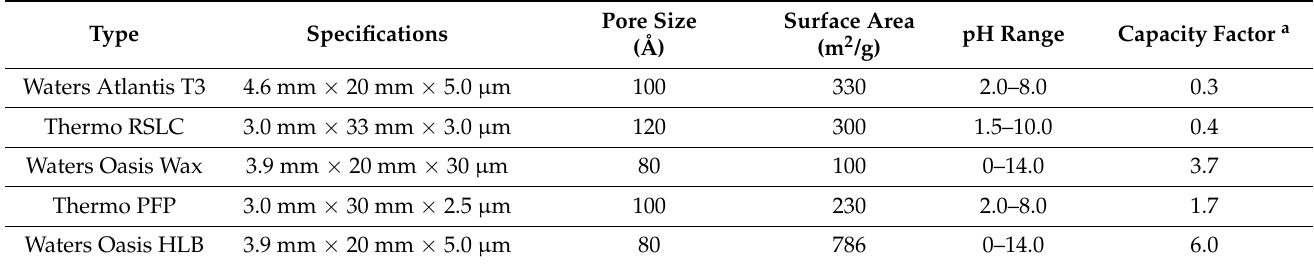
Table 1. Types and characteristics of five test columns for online SPE of